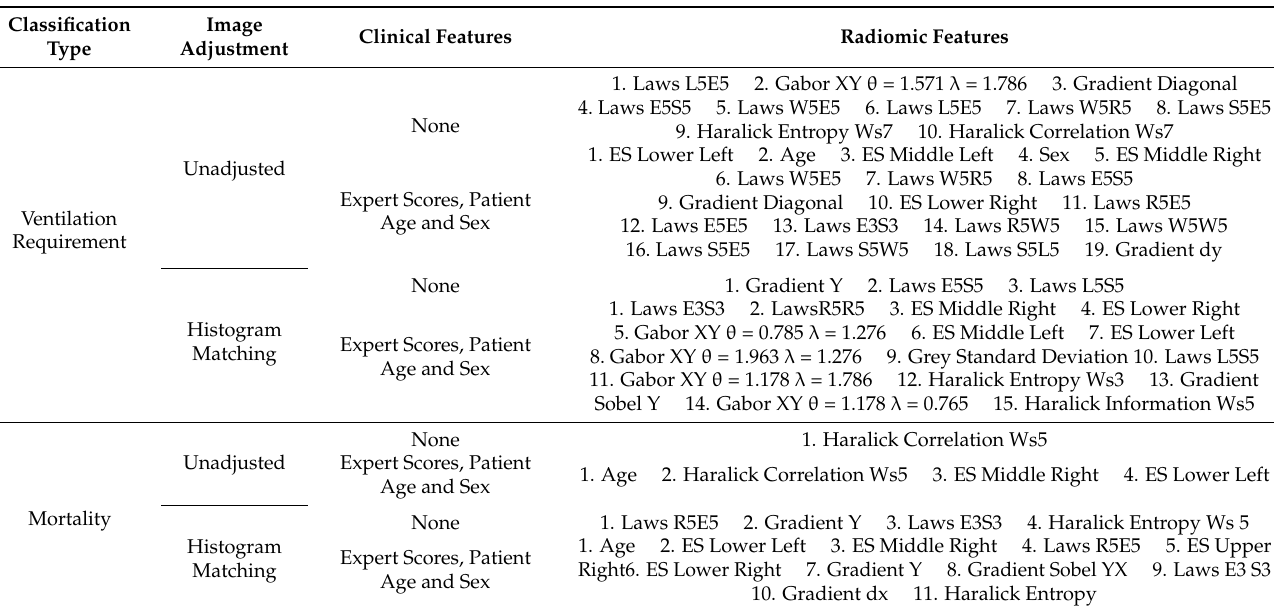
Table 7. Top 10 features used in radiomic